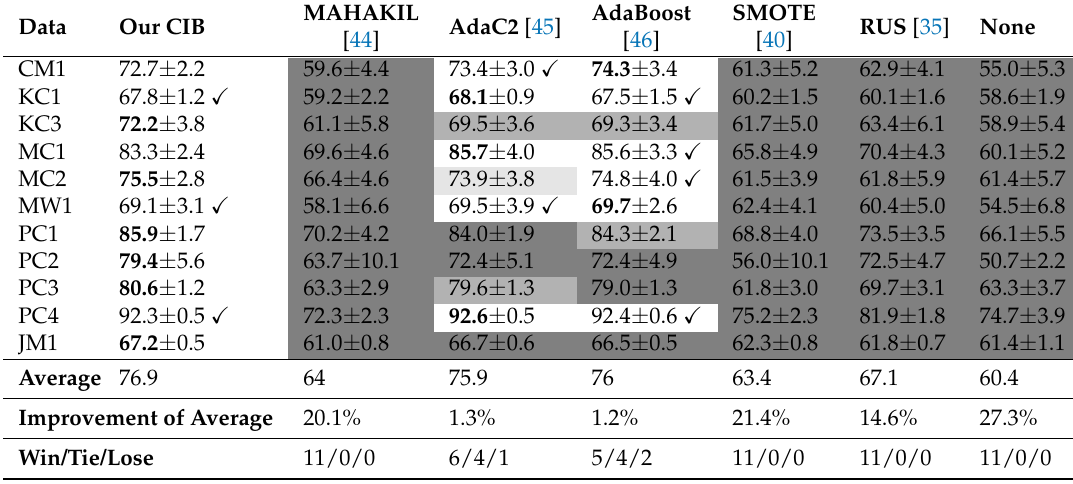
Table 7. The comparison results of AUC for our CIB and the baselines in the form of mean ± standard deviation. The best value is in